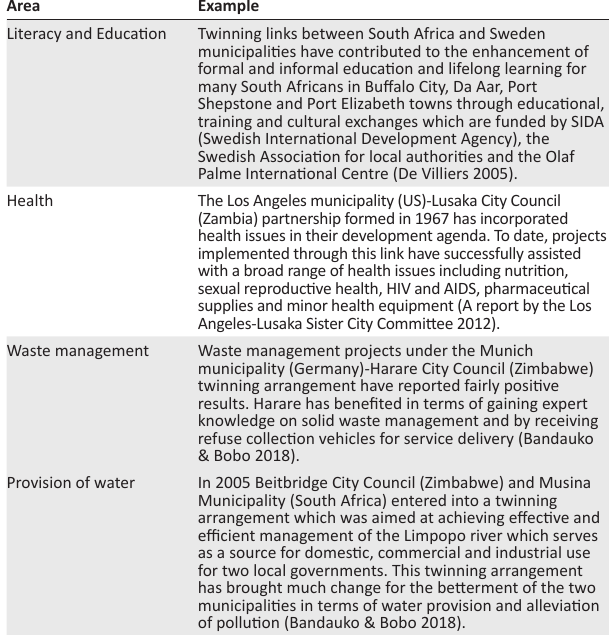
TABLE 1: Examples of improvements achieved in service delivery in developing